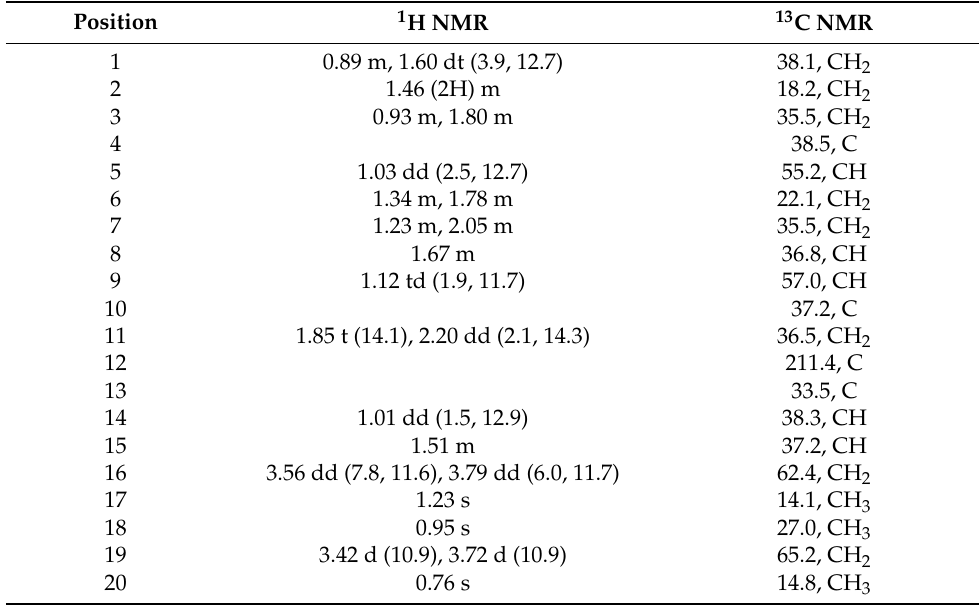
Table 2. 1 H (600 MHz) and 13 C (150 MHz) NMR data of compound 1 in CDCl 3 ( δ in ppm, J in